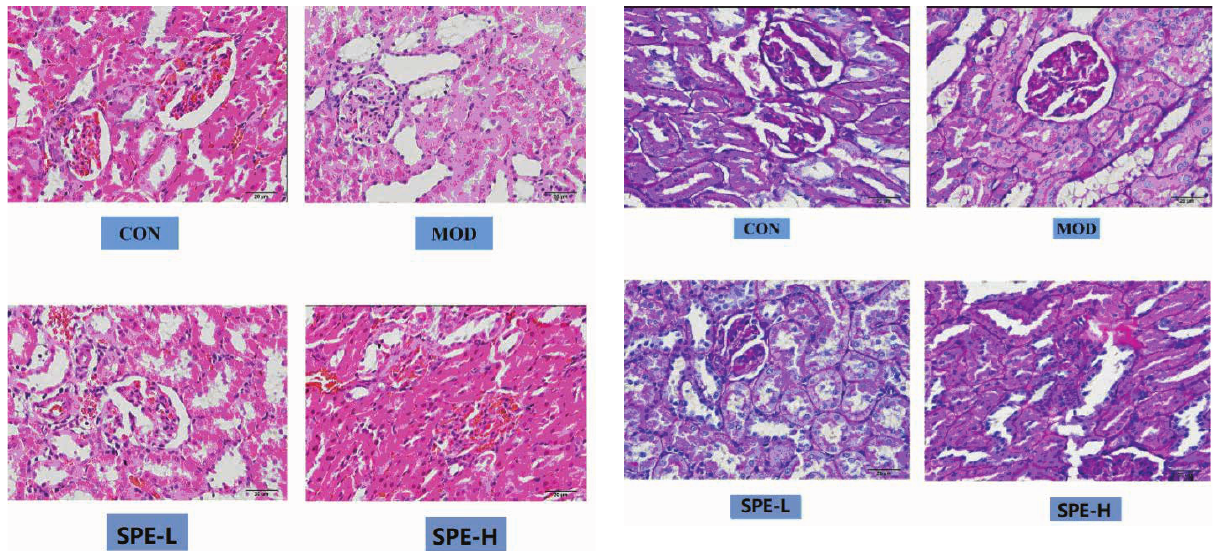
Figure 1: HE staining indicating the pathological changes in renal tissues. CON, control; MOD: model group; SPE-L, low dose group of SPE; SPE-H, high dose group of SPE.